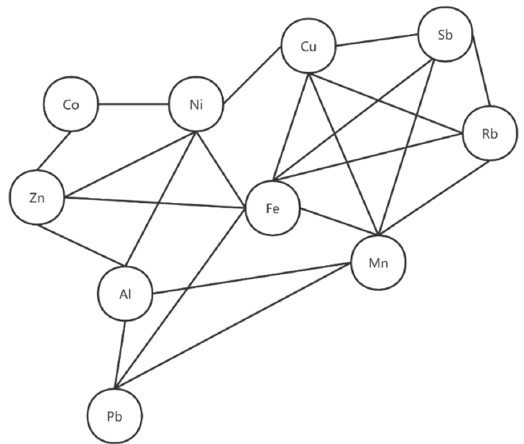
Figure 6. Toxic and essential trace elements’ correlation network in maternal plasma of pregnant women.